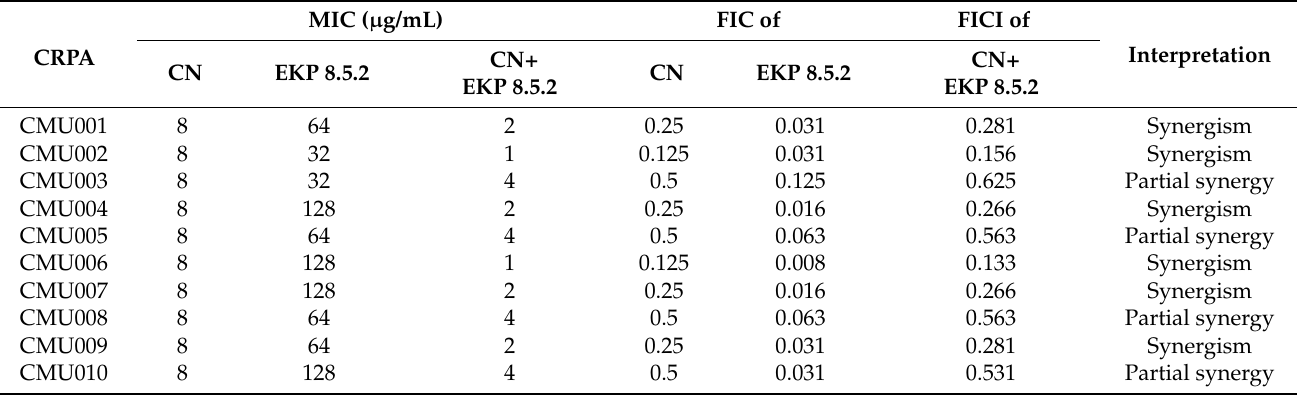
Table 5. Combination effect of gentamicin and EKP 8.5.2 extract against